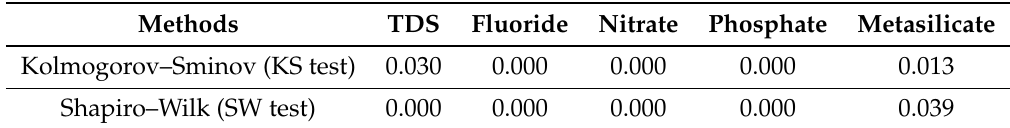
Table 2. KS test and SW test results of P